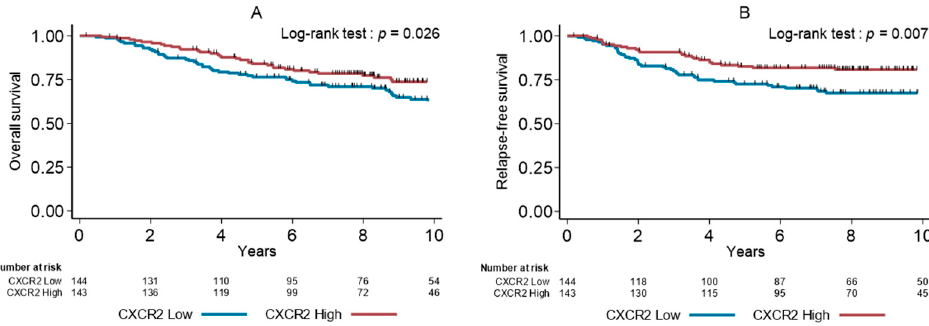
Figure 2. Overall survival ( A ) and relapse-free survival ( B ) in function of the tumor CXCR2+ cell density (median value used as cutoff) in the whole cohort of patients with TNBCs.